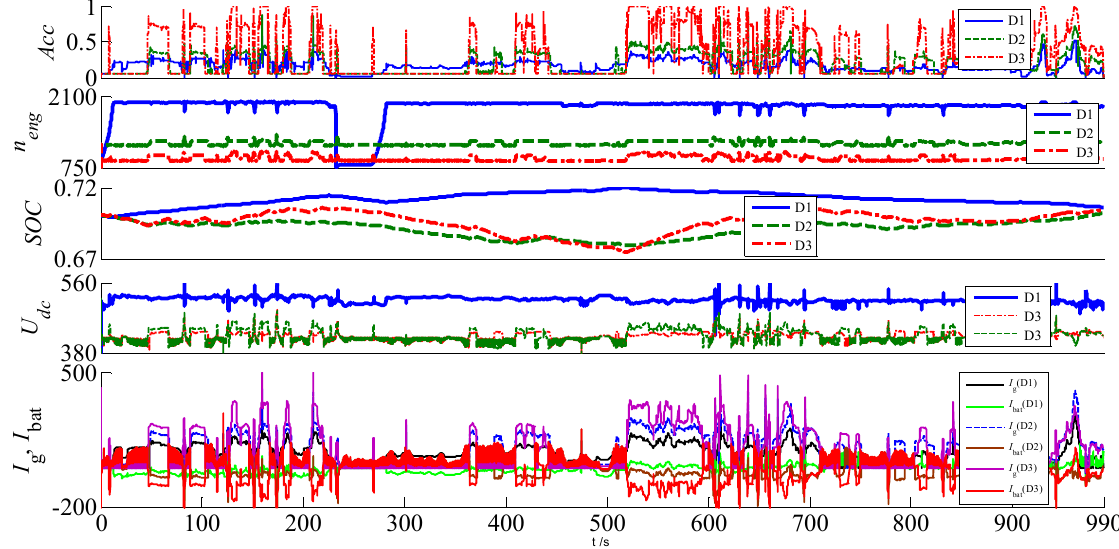
Figure 10. Dynamic history of typical variables in D 1, D 2, D